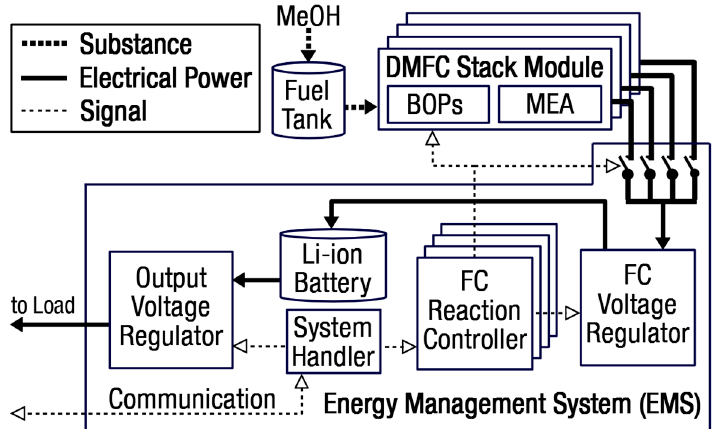
Figure 3. Semi-active DMFC power station functional block diagram.